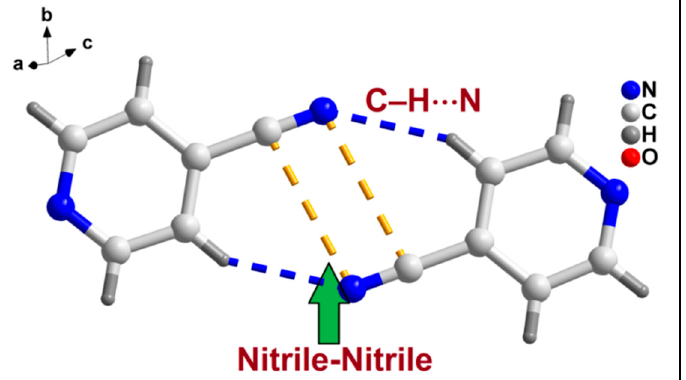
Figure 3. Formation of supramolecular dimer of co-crystal 2 involving 4-CNpy moieties assisted